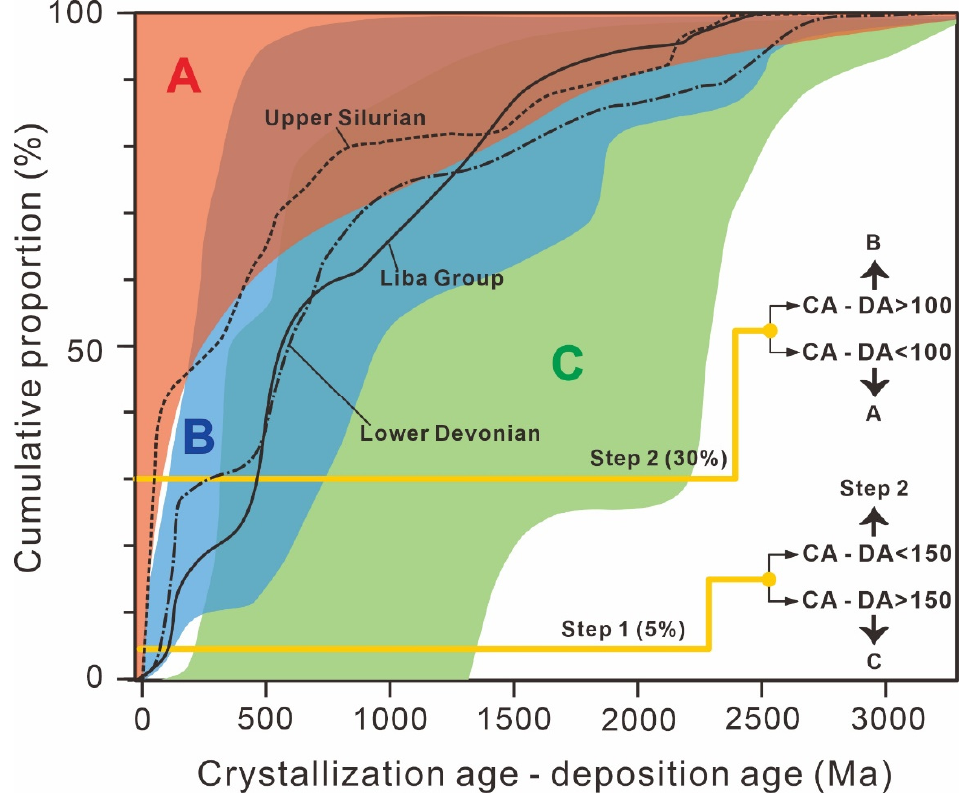
Figure 10. Detrital zircon U–Pb age cumulative probability distributions. Summary plot of the general fields for convergent (A: orange field), collisional (B: blue field), and extensional basins (C: green field). Extensional setting shows CA-DA > 150 Ma in 5% of the youngest zircon grains (step 1), convergent setting shows CA-DA < 100 Ma in 30% of the youngest zircon grains (step 2), and collisional setting shows CA-DA < 150 Ma and CA-DA > 100 Ma in 5% and 30% of the youngest zircon population, respectively (modified after